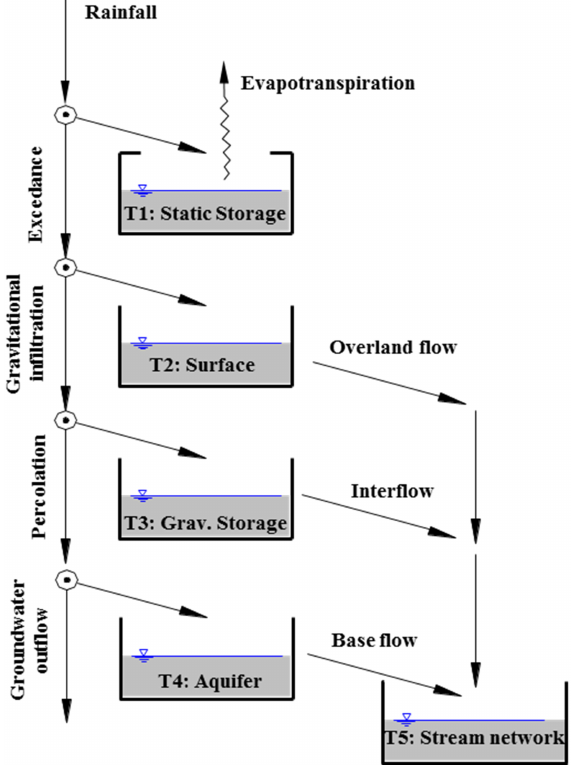
Fig. 1. TETIS hydrological components: vertical conceptual scheme.